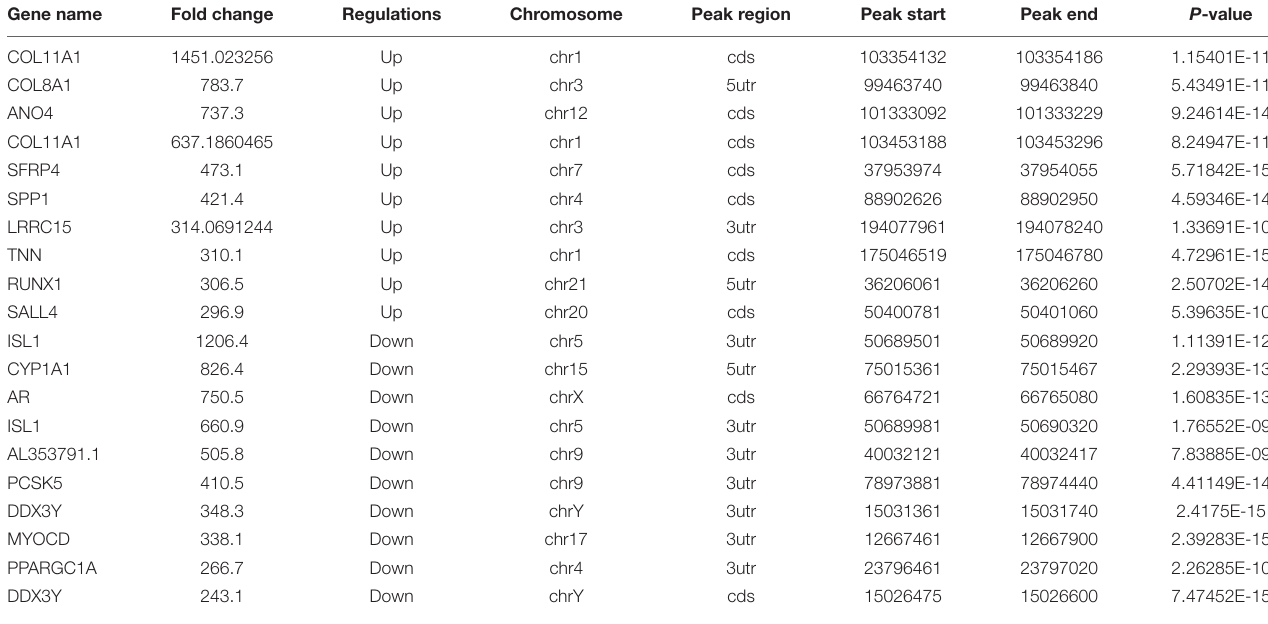
TABLE 3 | The top 20 differently expressed m6A peaks (SC vs.